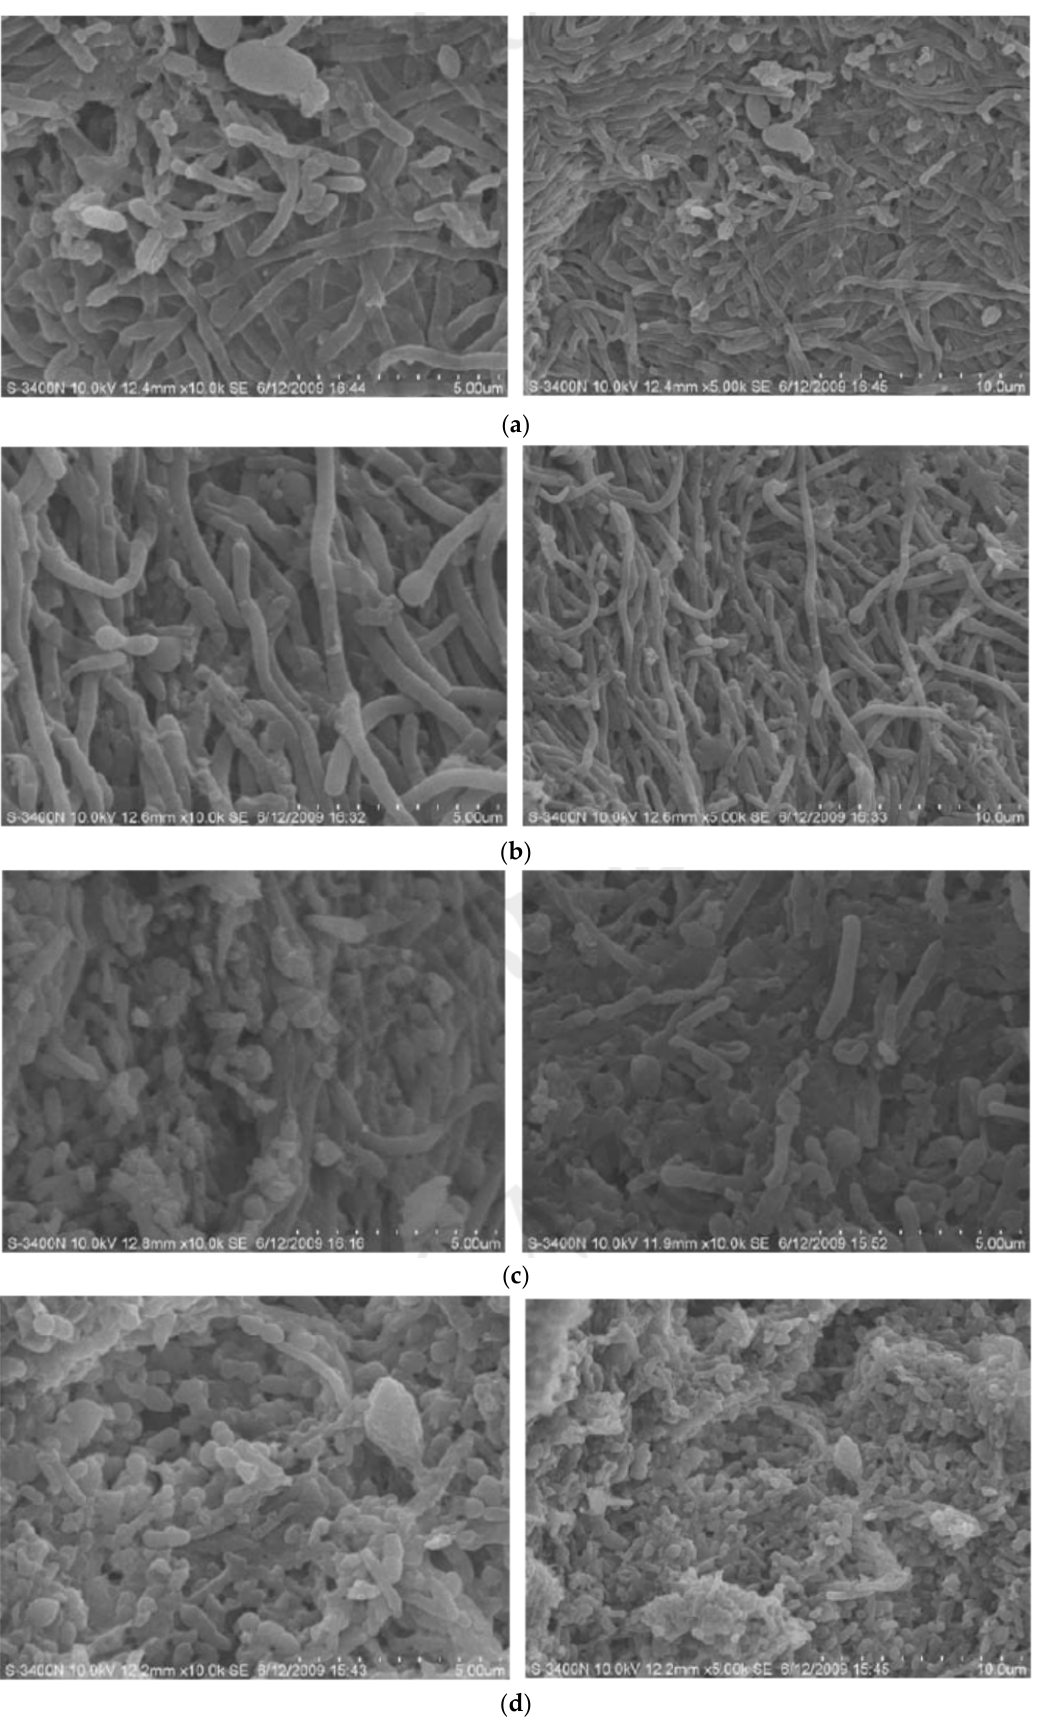
Figure 3. ( a ) Morphology of anaerobic-activated sludge (AnAS) in Compartment I at Stage III; ( b ) morphology of AnAs in Compartment II at Stage III; ( c ) morphology of AnAs in Compartment III at Stage III; ( d ) morphology of AnAs in Compartment IV at Stage